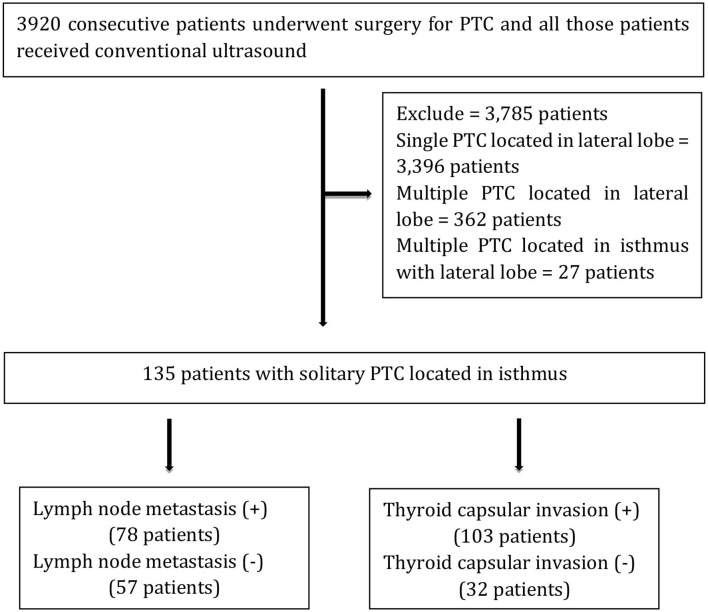
Flowchart of the study. +, pathological LN metastasis and capsular invasion; –, pathological no LN metastasis and capsular invasion.